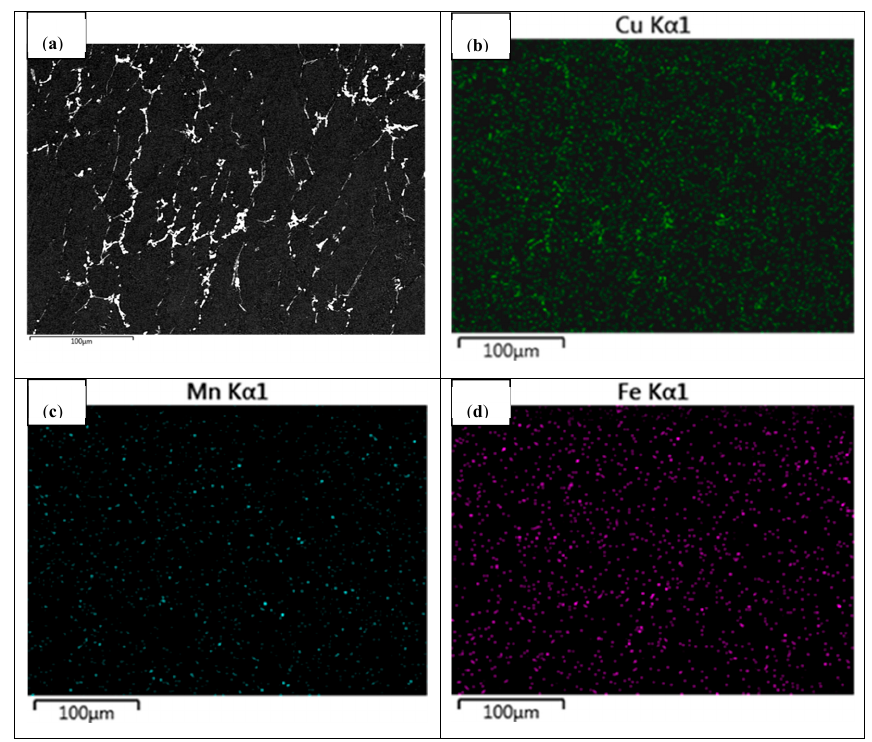
Figure 5. BSEM microstructures and main elements distribution of the as-cast 2219 aluminum alloy: ( a ) BSEM image; ( b ) Cu; ( c ) Mn; ( d )